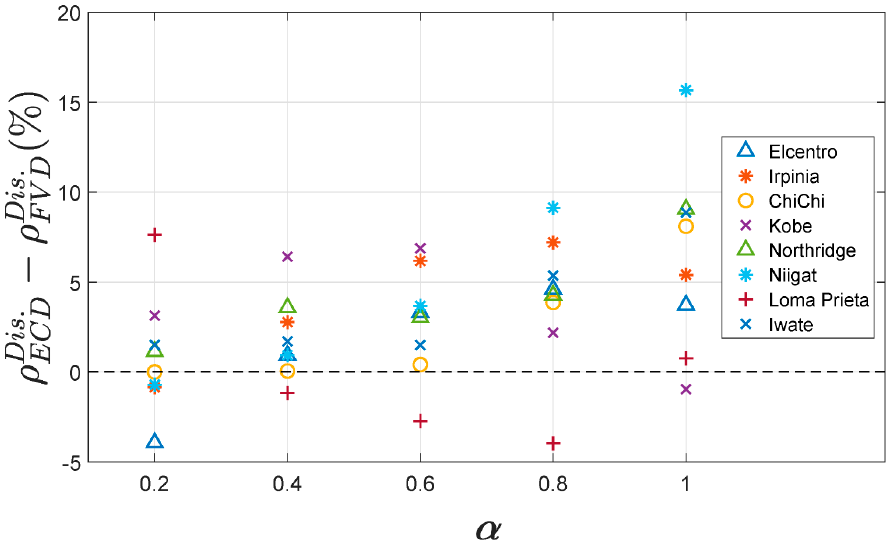
Figure 9. Displacement reduction ratios under di ff erent earthquakes.